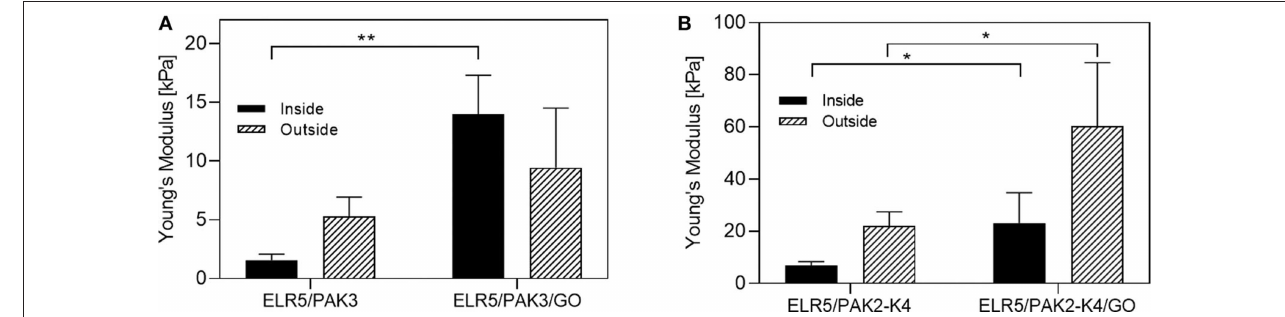
FIGURE 6 | Young’s Moduli of the membranes. AFM measurements were carried out on the luminal (inner) and abluminal (outer) side of the ELR5/PAK3 ± GO membranes (A) and ELR5/PAK2-K4 ± GO membranes (B) . Error bars represent ± SEM where ** p < 0.01, and * p < 0.5. The experiments were performed in 5